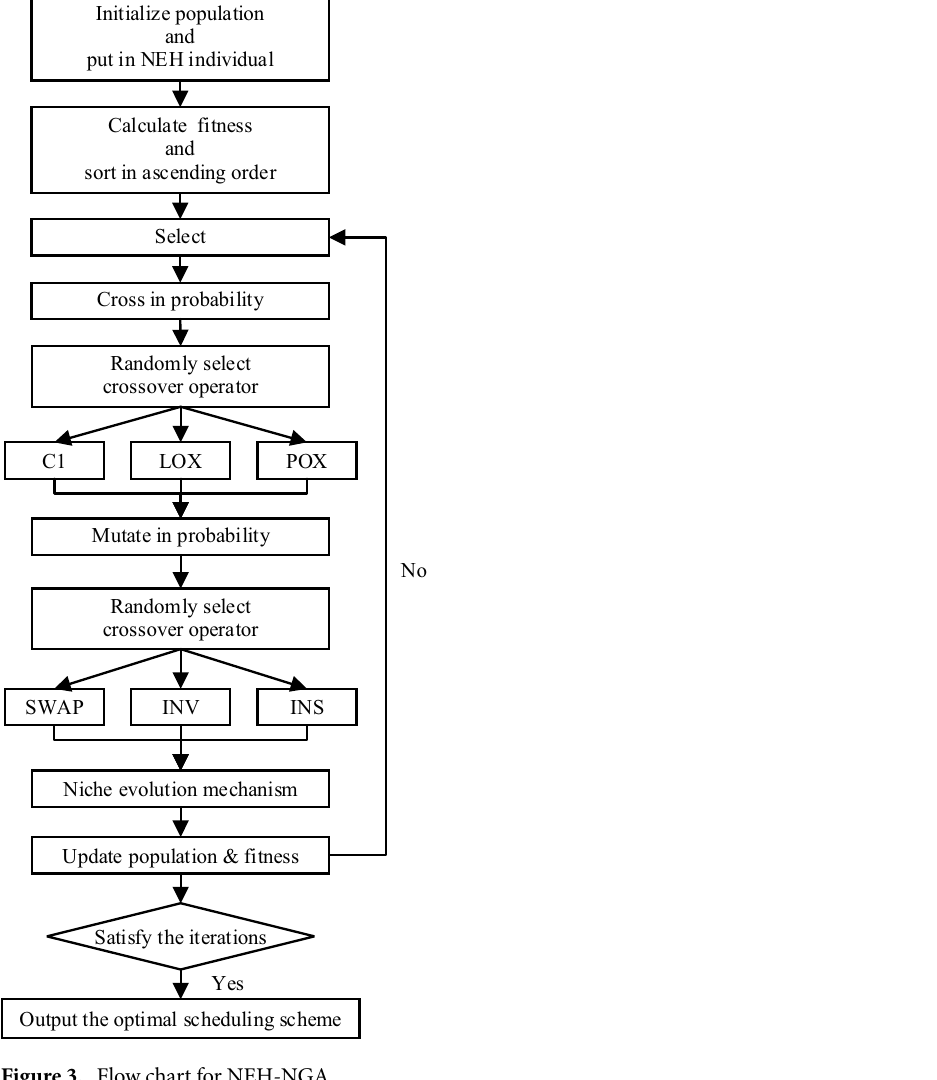
Figure 3. Flow chart for